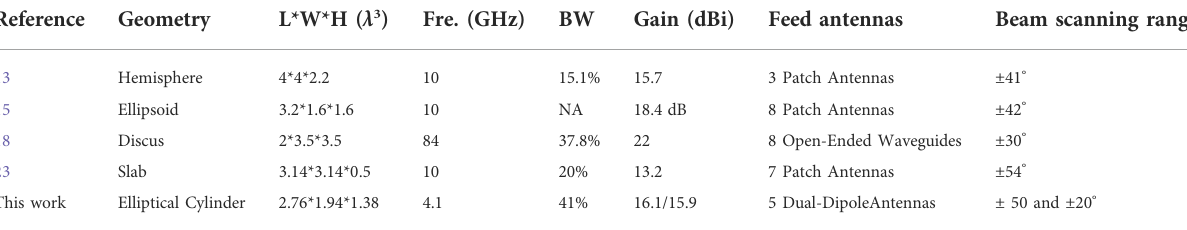
TABLE 3 Comparison between the proposed Luneburg lens and